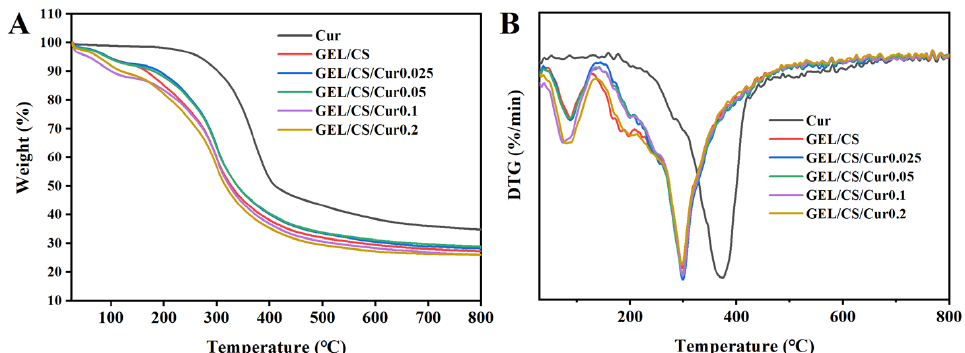
Figure 6. Thermogravimetric (TG) ( A ) and derivative thermogravimetric (DTG) ( B ) thermograms of Cur powder, GEL/CS, and GEL/CS/Cur composite films.